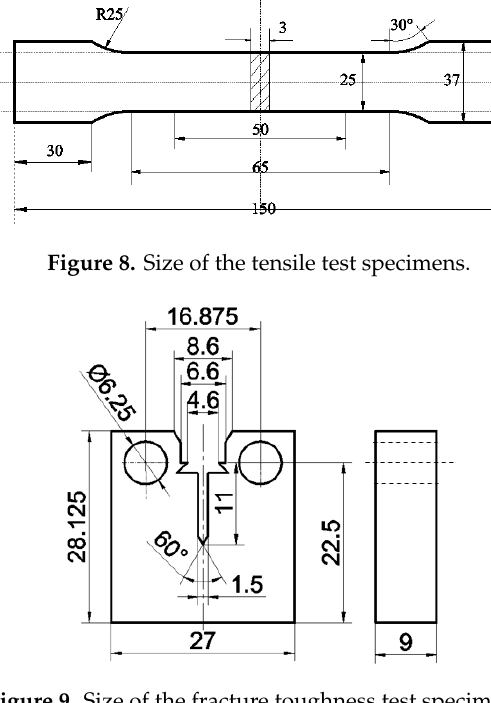
Figure 9. Size of the fracture toughness test specimens.